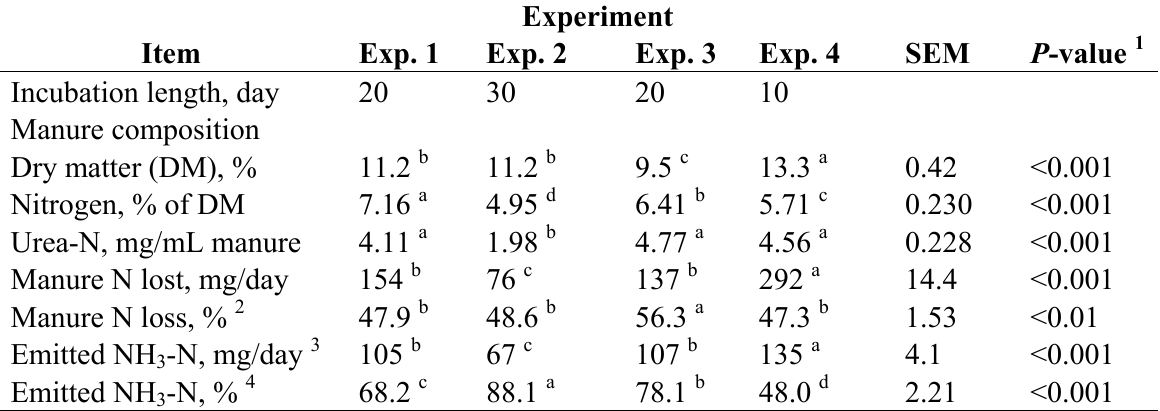
Table 1. Manure composition, nitrogen losses, and ammonia emissions in Experiments 1, 2, 3, and 4 (least squares means; n = 3 in Exp. 1, 2, and 3 and n = 8 in Exp.